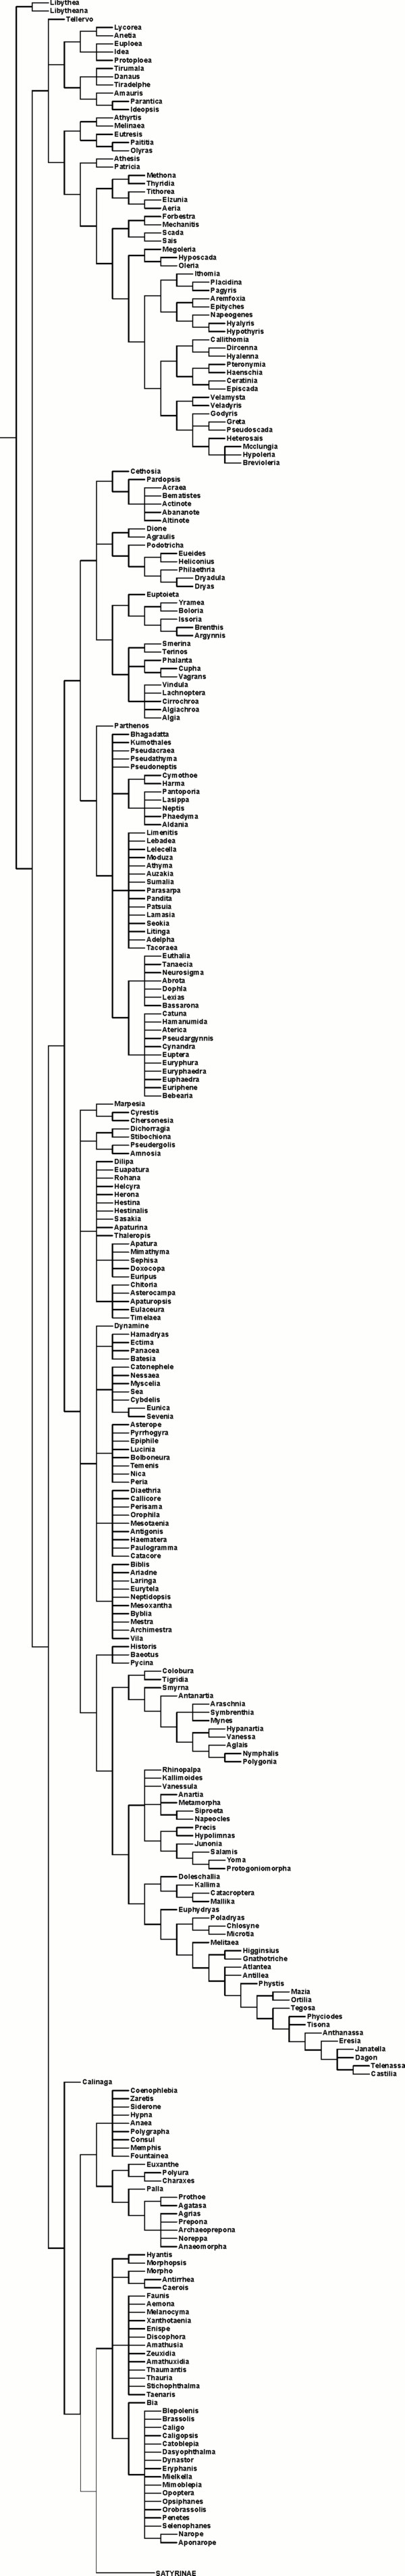
Phylogeny of the Nymphalidae. The phylogeny was compiled from several sources, using both molecular and morphological data (see Material and Methods for further information on the phylogenetic reconstruction and the sources used). It is resolved to the genus level, with the exception for the subfamily Satyrinae, which, due to little variation in host use, were counted as one contrast in the analysis.